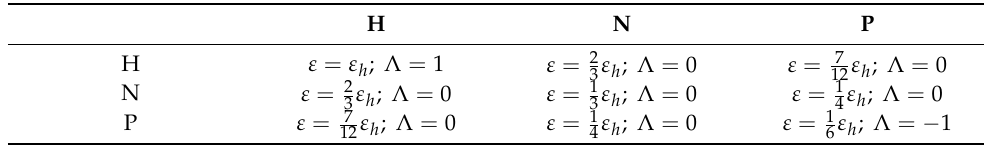
Table 1. Parameters ε and Λ in the non-bonded interaction term of the potential function depending on the nature of the two residues